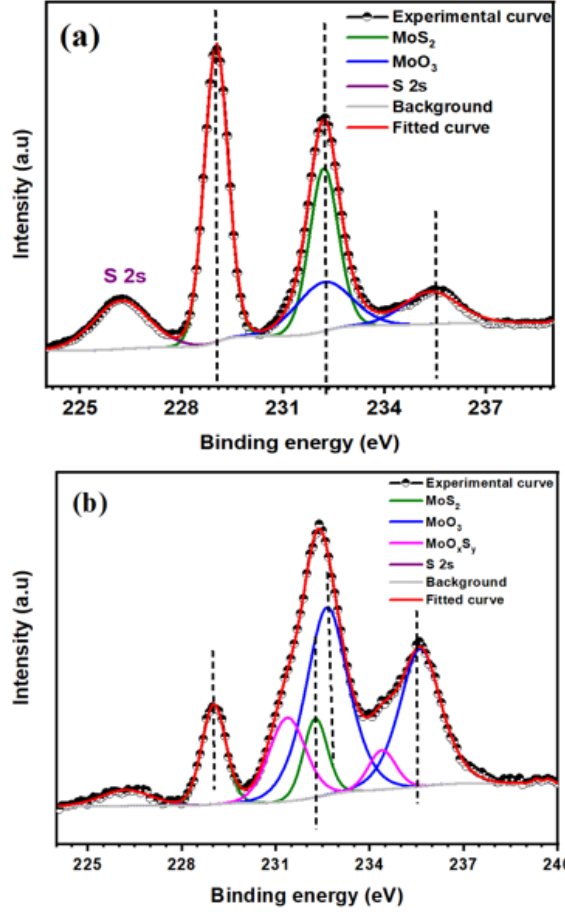
Figure 6. Mo 3d XPS spectra of ( a ) MoS 2 thin layer and ( b ) MoO 3 :MoS 2 reaction duration of 10 min.